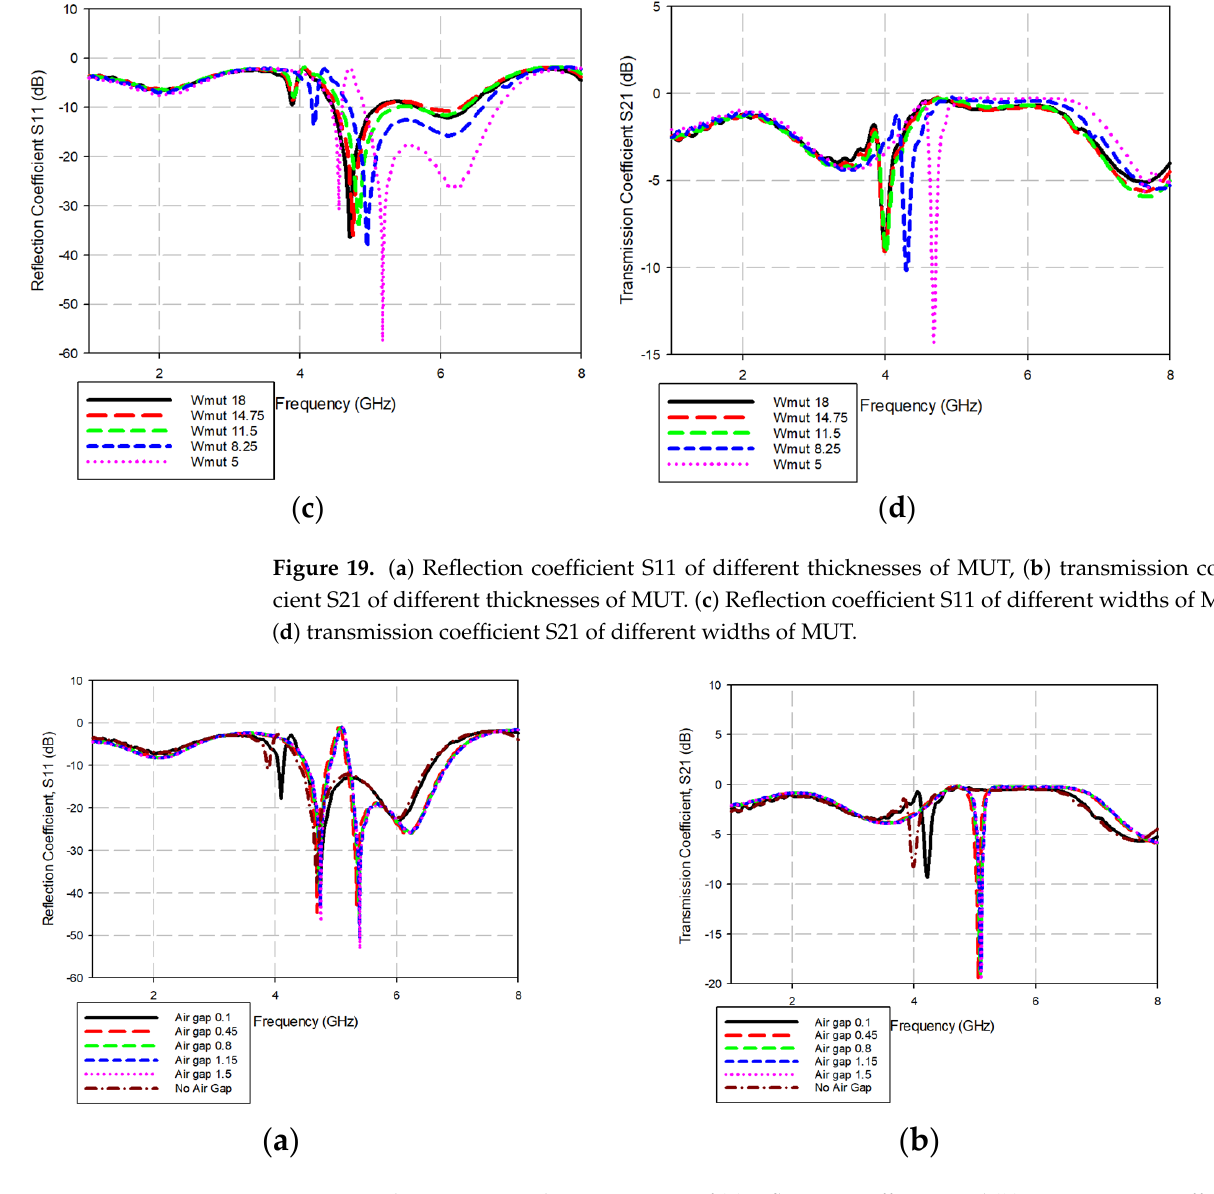
Figure 20. The air gap simulation response of ( a ) re fl ection coe ffi cient and ( b ) transmission coe ffi - cient between MUT and resonator.